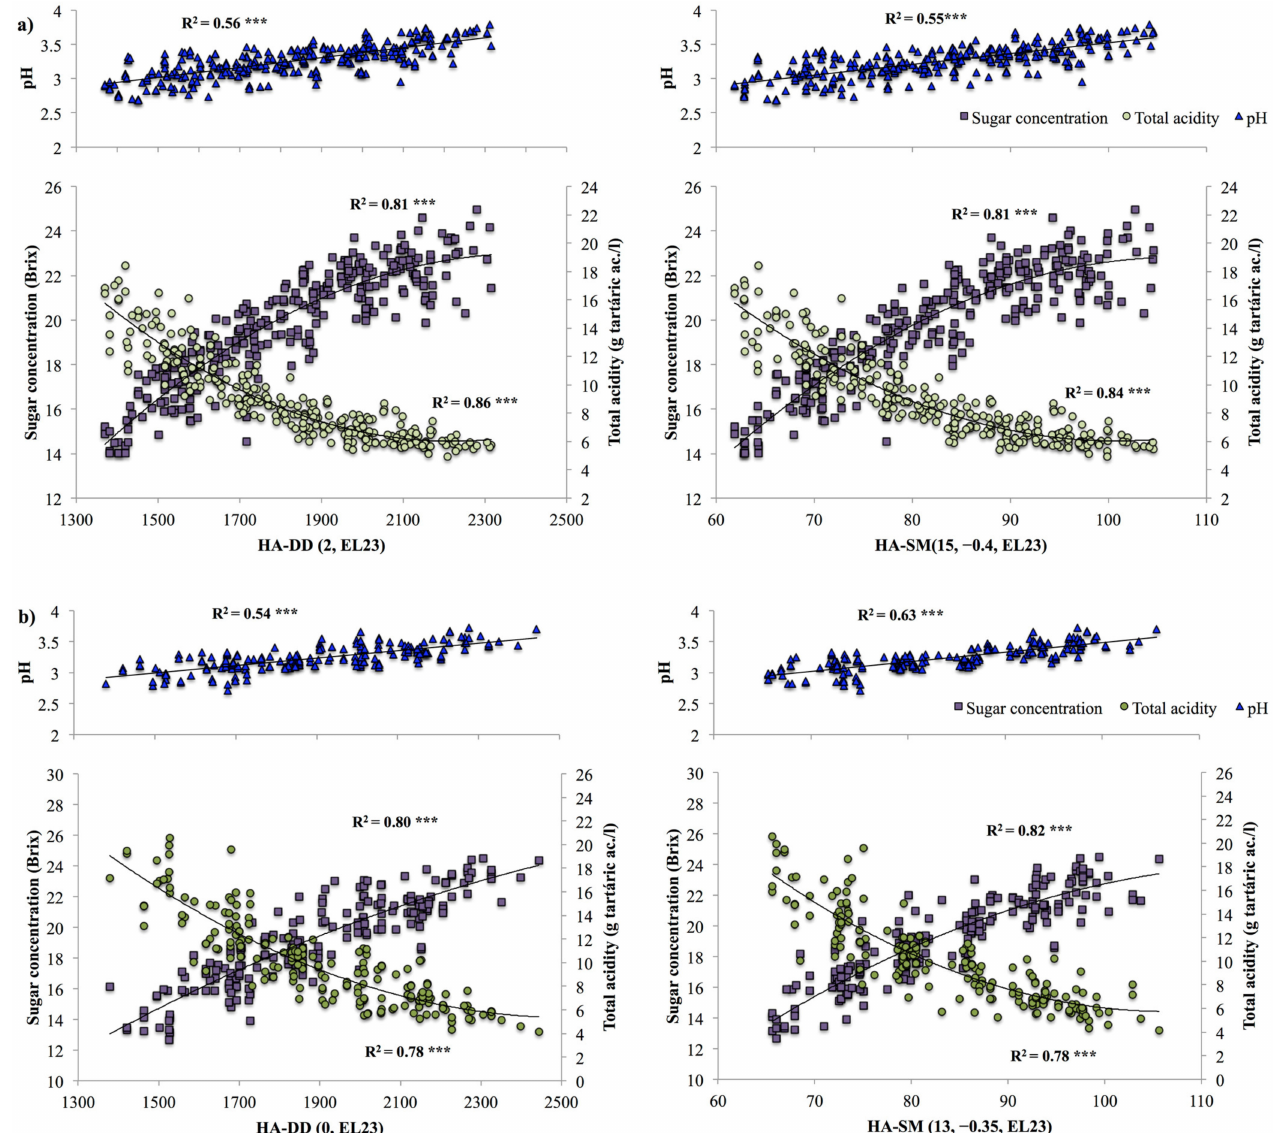
Figure 6. Relationship between sugar concentration ( ◦ Brix), total acidity (TA), and pH of the grape must and corresponding heat accumulation (HA), calculated either with DD or SM and for ( a ) TN and ( b ) EN. *** p -value ≤